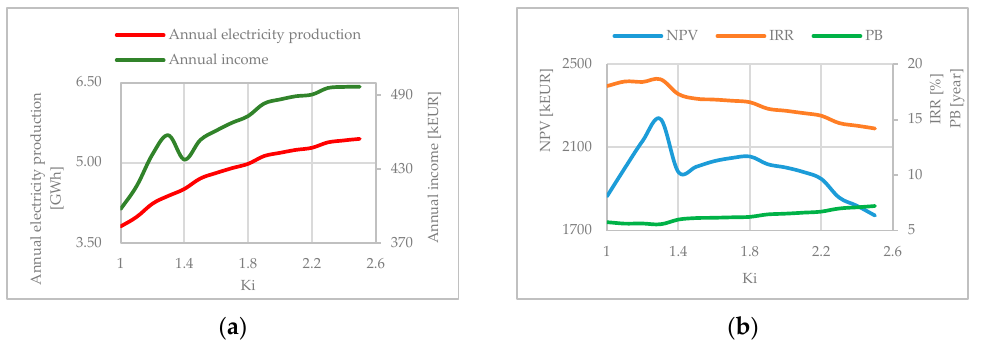
Figure 6. ( a ) Annual electricity production and income—Bistrica Lipovska SHPP; ( b ) NPV, IRR, and